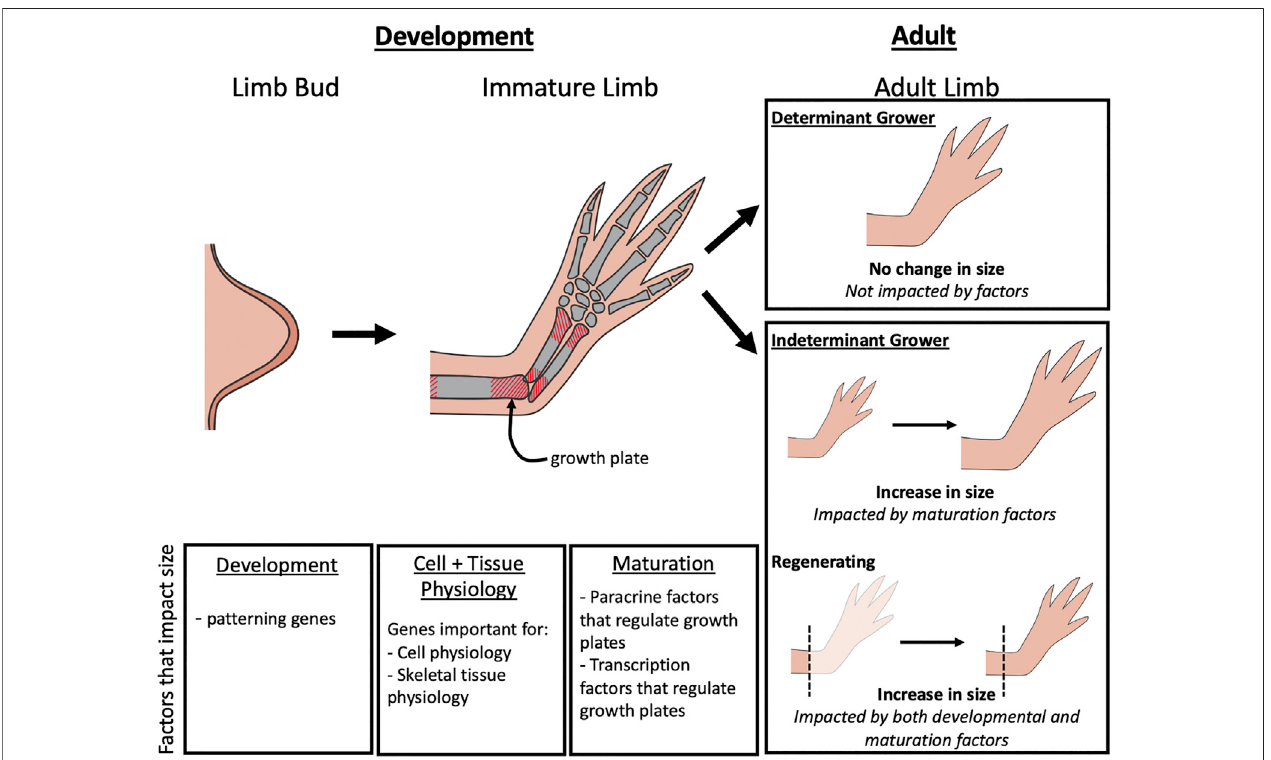
FIGURE 1 | Factors that impact limb growth. During limb bud development, changes in limb patterning genes can lead todifferences in the overall size ofthe adult limb. Asthe immature limbelongates, sizeiscontrolledbyparacrinefactors andtranscriptionfactors thatregulategrowth ofthe growth plates.Inadult limbs, thefactors that in fl uence size is dependent on the type of organismal growth type (determinant or indeterminant) and whether regeneration is occurring. Limb size on determinant growers will not be impacted by regulation during adulthood, but in indeterminant growers, limb size can be impacted by maturation factors that alter growth plate activity. During regeneration, both development and maturation factors can in fl uence limb